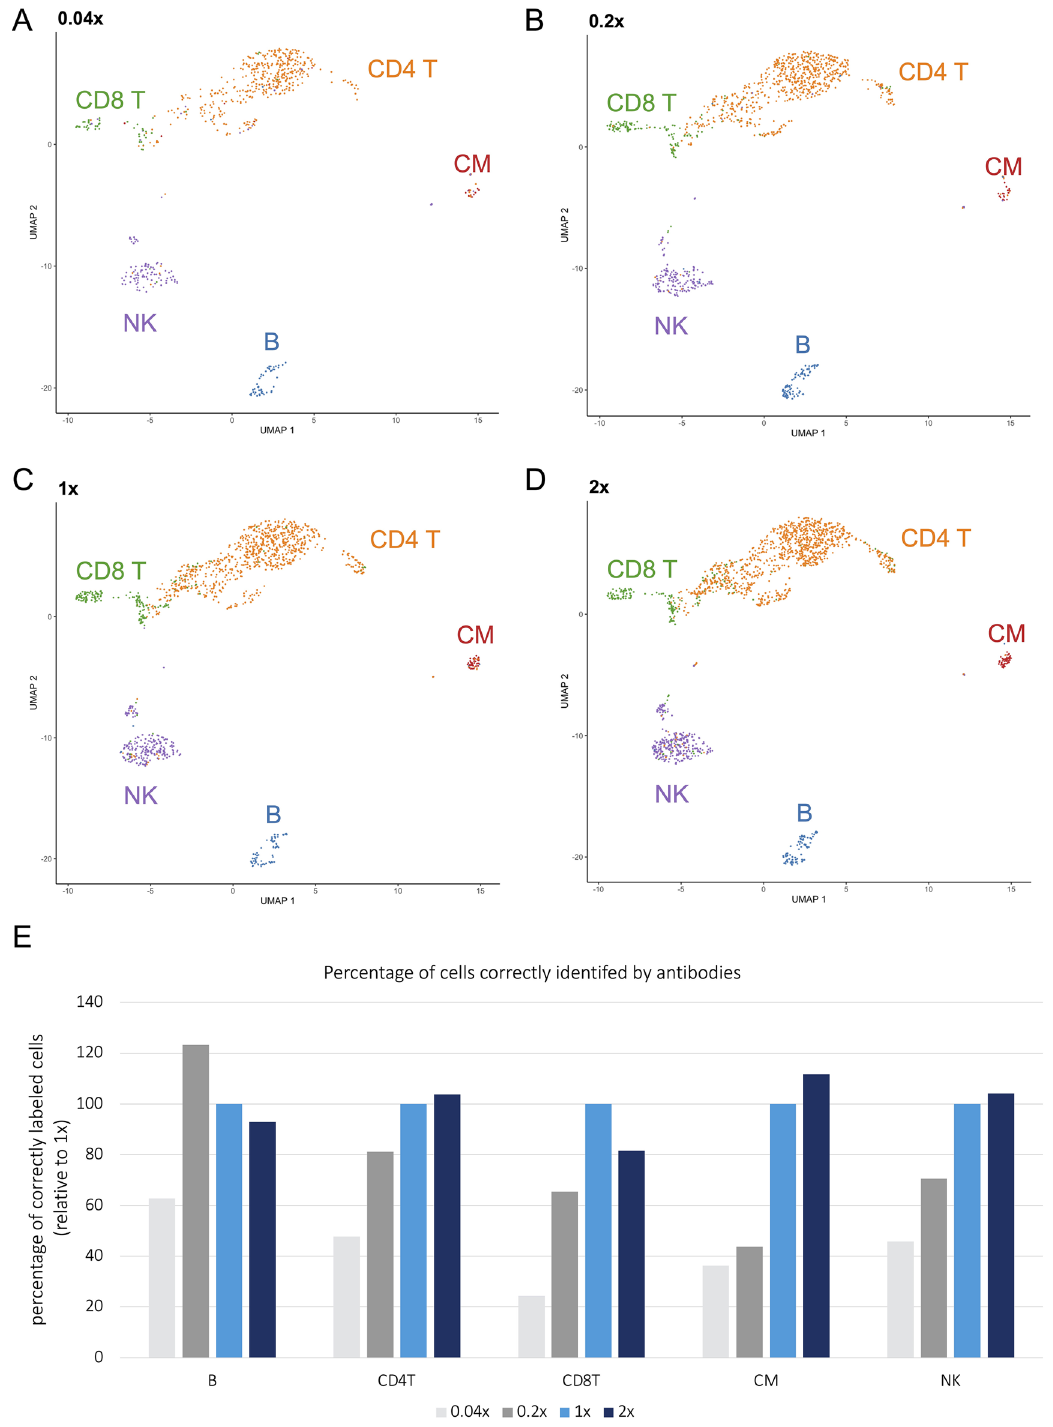
Figure 1. Major cell type identification at different antibody concentrations. ( A – D ) Major cell types detected by antibodies at the indicated concentrations were projected on a unified UMAP, in which all cells are clustered by transcriptomes. Major cell type clusters were clearly separated at all concentrations, although antibody dilution reduced the number of identified cells. ( E ) Percentage of correctly identified major cells at different antibody concentrations in relation to 1 ×. Proportions of all major cell types in relation to the total number of cells detected were calculated for each concentration and normalized to the proportions of detected cells at the recommended concentration (1